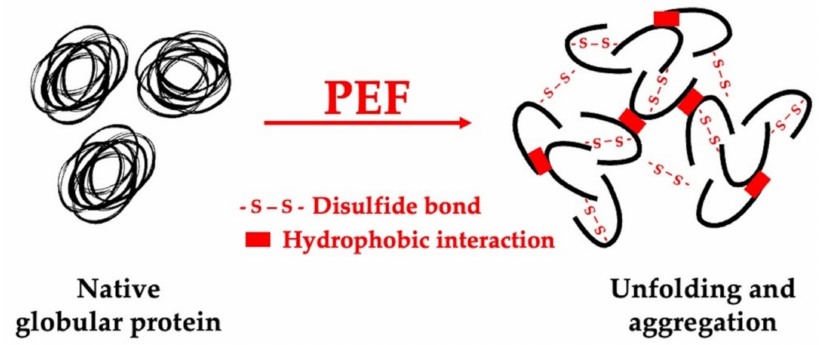
Figure 7. Schematic representation of PEF induction effect on globular protein